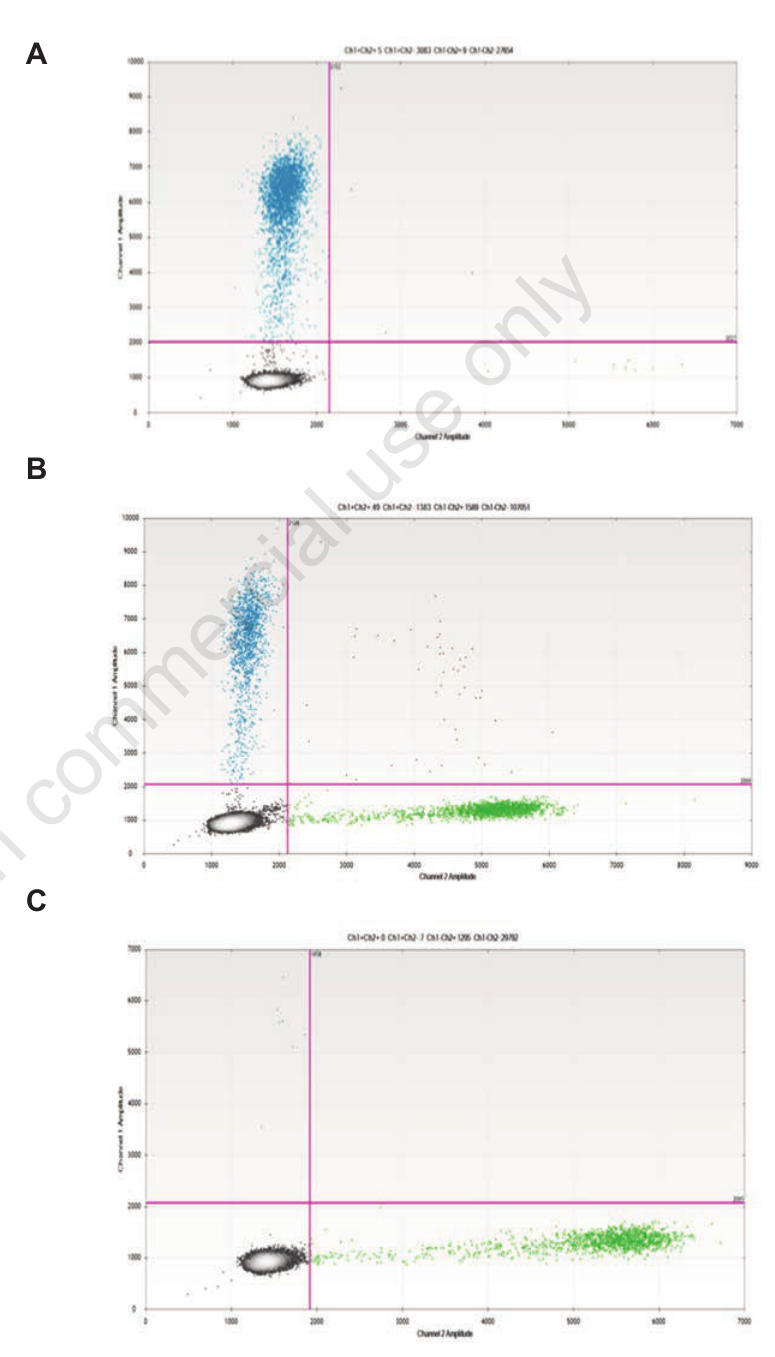
Figure 2. Here shows the image of the two-dimension chromatograms, generated using the QuantaSoft program, revealed specific patterns for a normal fetus (A), (SEA deletion) carrier (B) and Hb Bart’s hydrops fetalis fetus